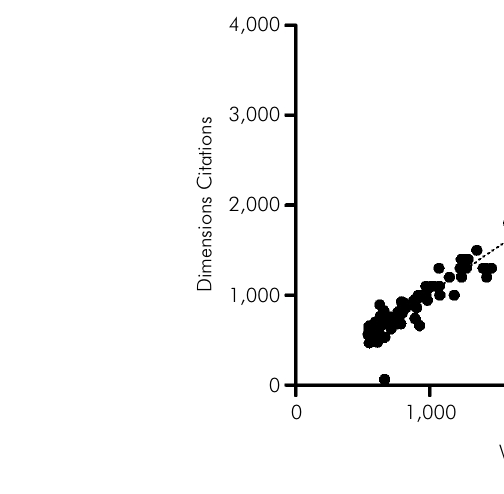
Figure 2. Scatter plot examining the relationship between WOS citations and Dimensions